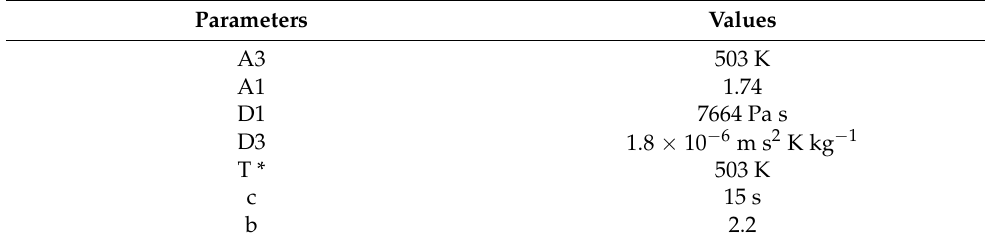
Table 3. Constants adopted in Equations (1)–(10).